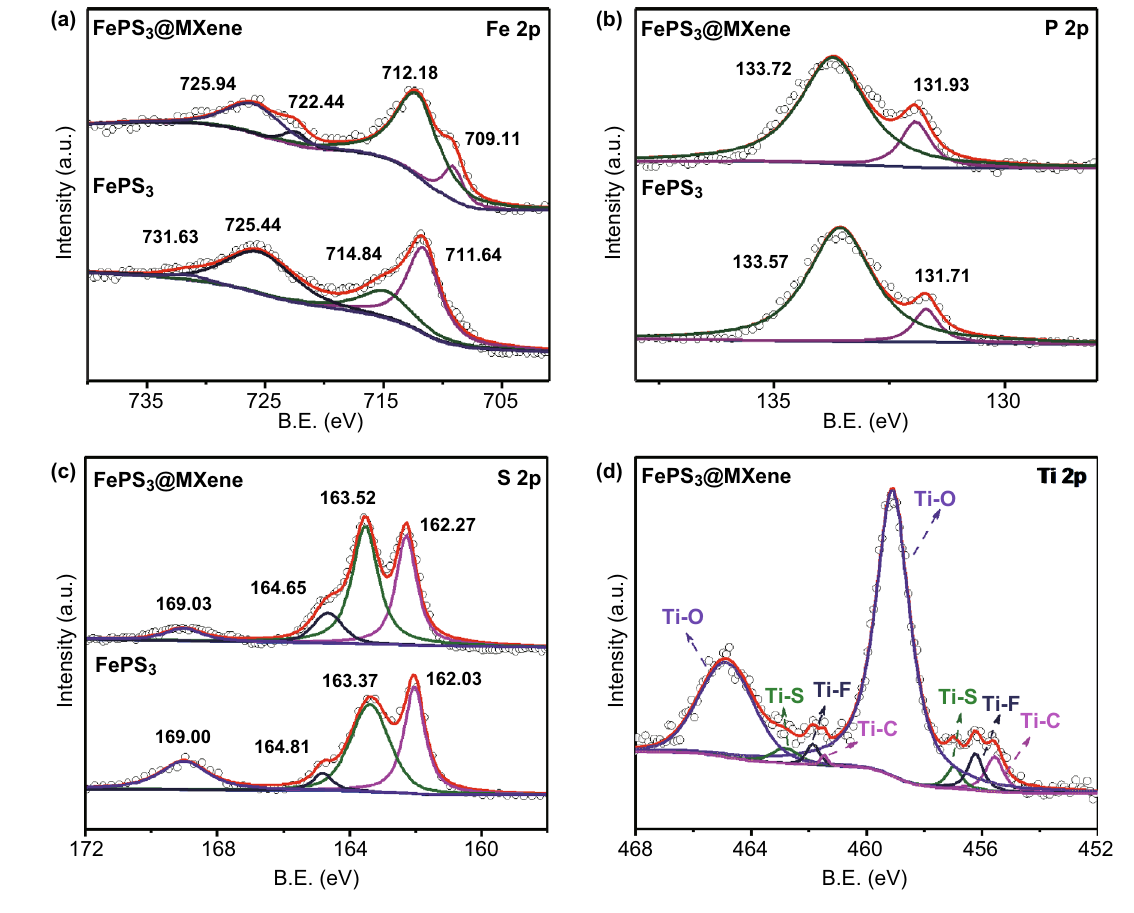
Fig. 4 XPS spectra of a Fe 2p, b P 2p, c S 2p, and d Ti